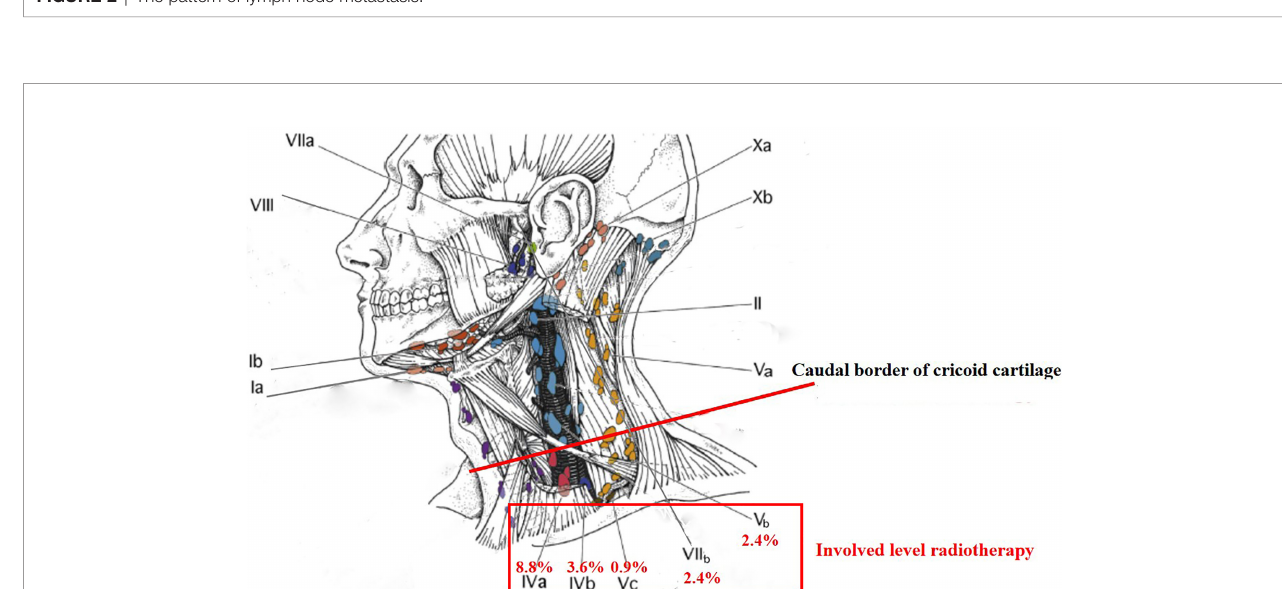
FIGURE 2 | The pattern of lymph node metastasis.